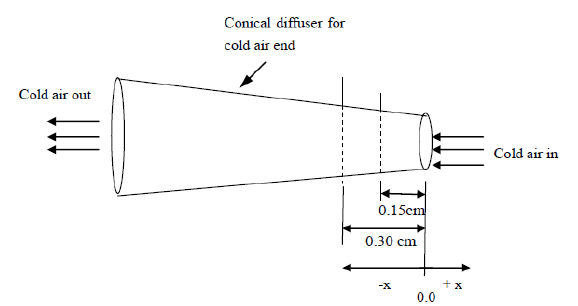
Figure 4. Dotted lines show planes in the cold air side of vortex tube where temperature measurements were made for com- parison with model